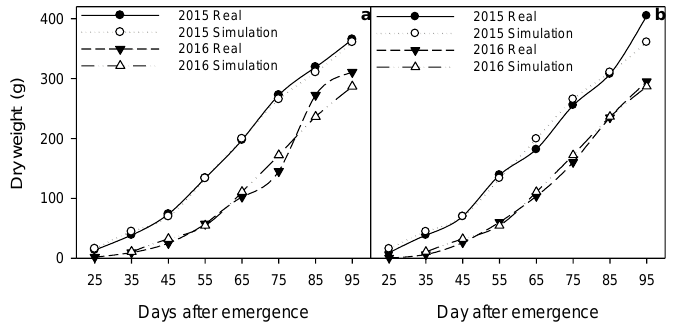
Figure 4. Comparison between the real and dynamically simulated data for the accumulation of dry biomass in cucumber plants for Vitaly ( a ) Luxell ( b ) varieties. The real data is the average of four replicates.